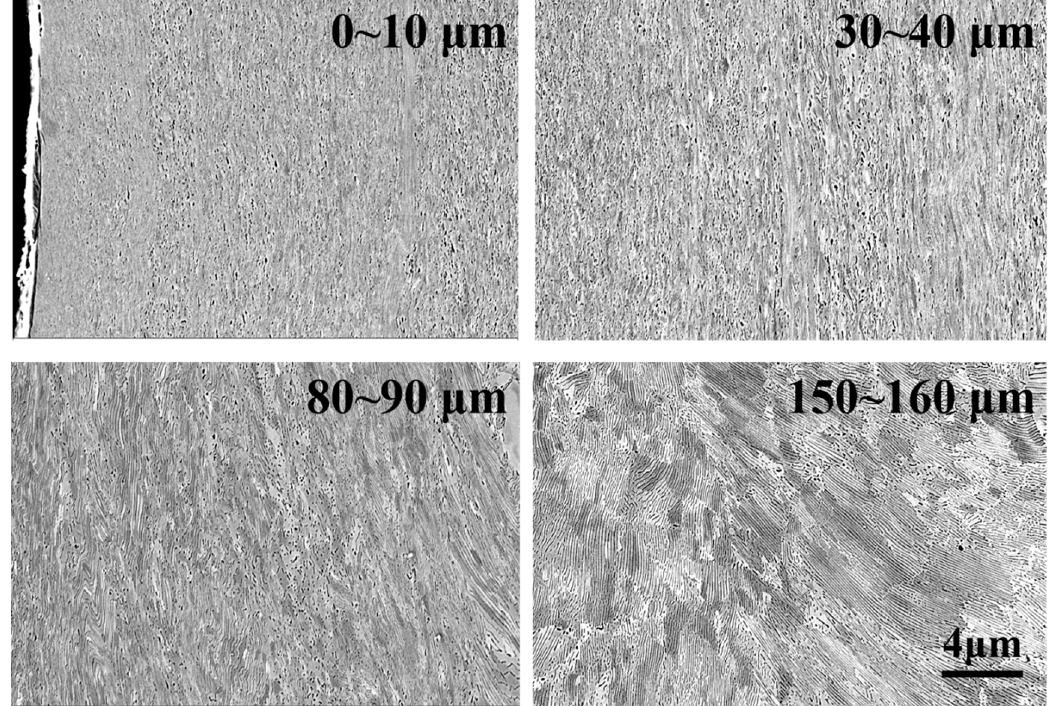
Figure 10. The SEM micrograph of rail samples from different positions in the top surface under contact stress of 1200 MPa. stress of 1200